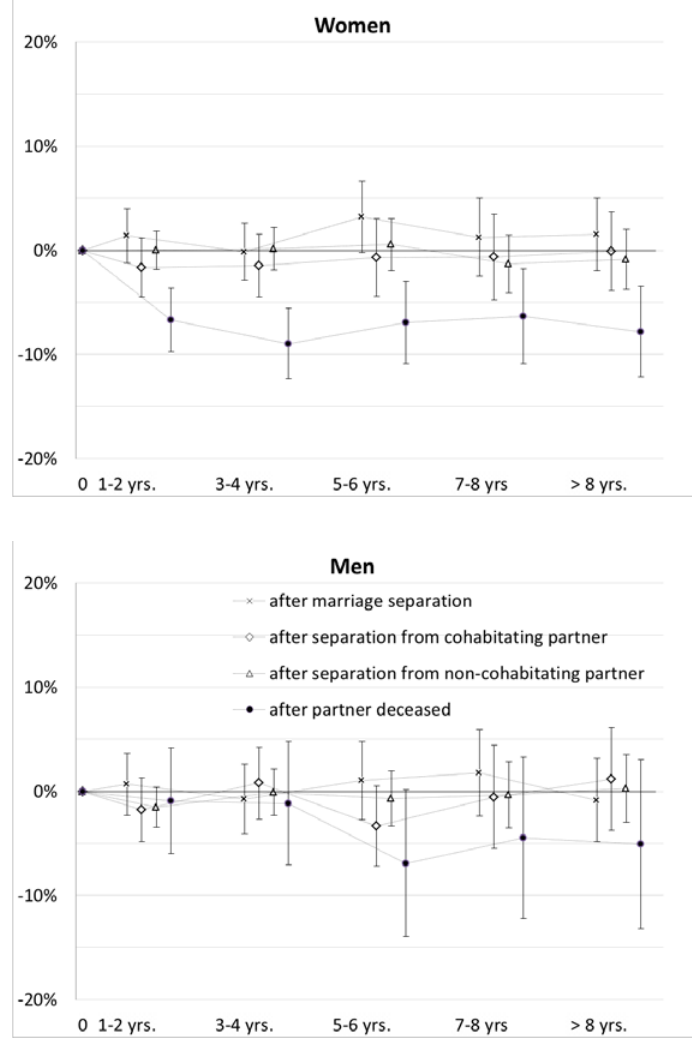
Figure 3 : Time-effects of relationship endings on social isolation (linear-probability models with fixed effects, percentage points and 95%-confidence limits)